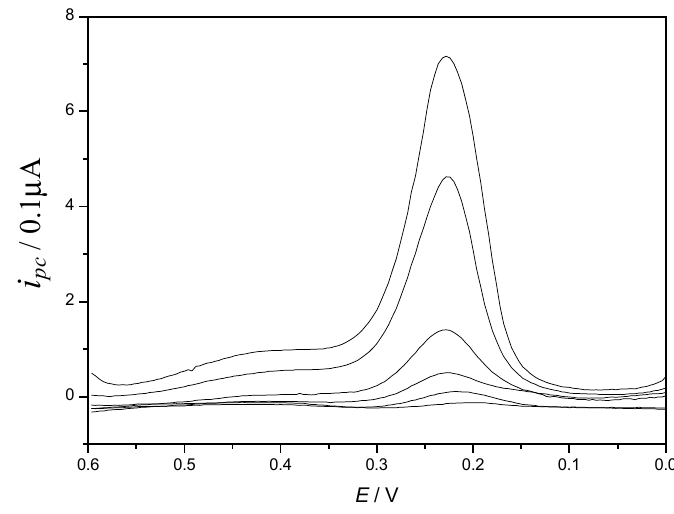
Figure 6. SWV graphs of NE at different concentrations (from bottom to top): 2.0, 6.0, 10.0, 20.0, 60.0, 100 µ M.